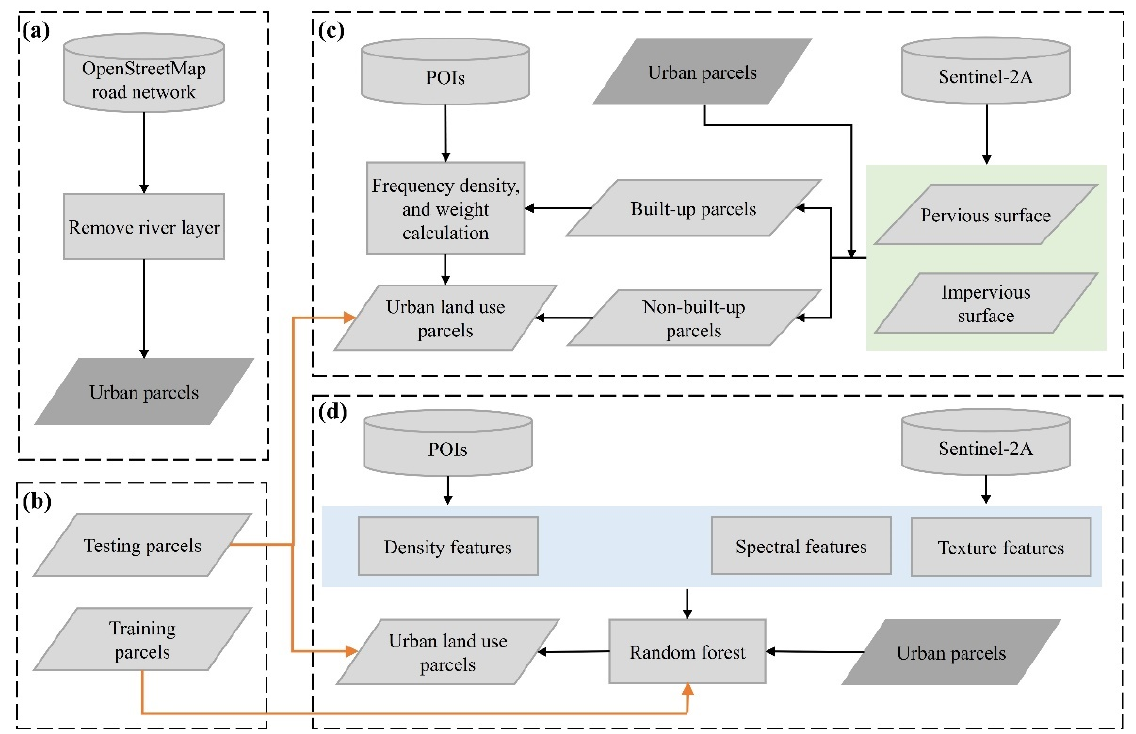
Figure 3. This is a figure. Schemes follow the same formatting. Research methodological framework of mapping urban land use with decision-level integration (DI) and feature-level integration (FI). ( a ) Urban parcel generation based on the road network and river data; ( b ) Collection of testing and training parcels; ( c ) DI-based urban land use mapping (DI); ( d ) FI-based urban land use mapping.